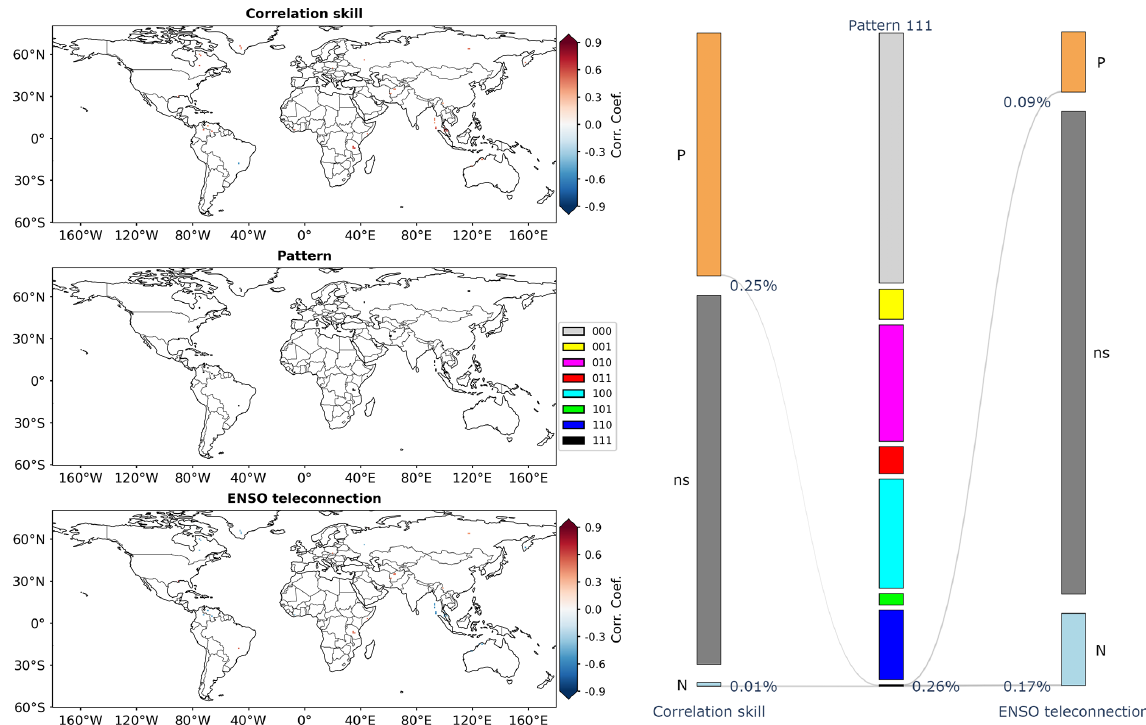
Figure 10. As for Fig. 4 but for pattern 111.